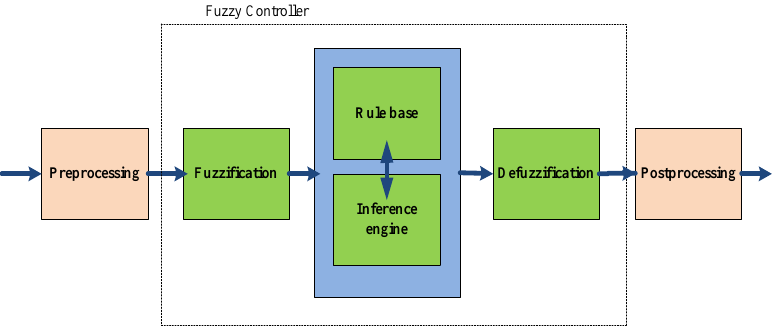
Figure 7. Blocks of a fuzzy logic controller.